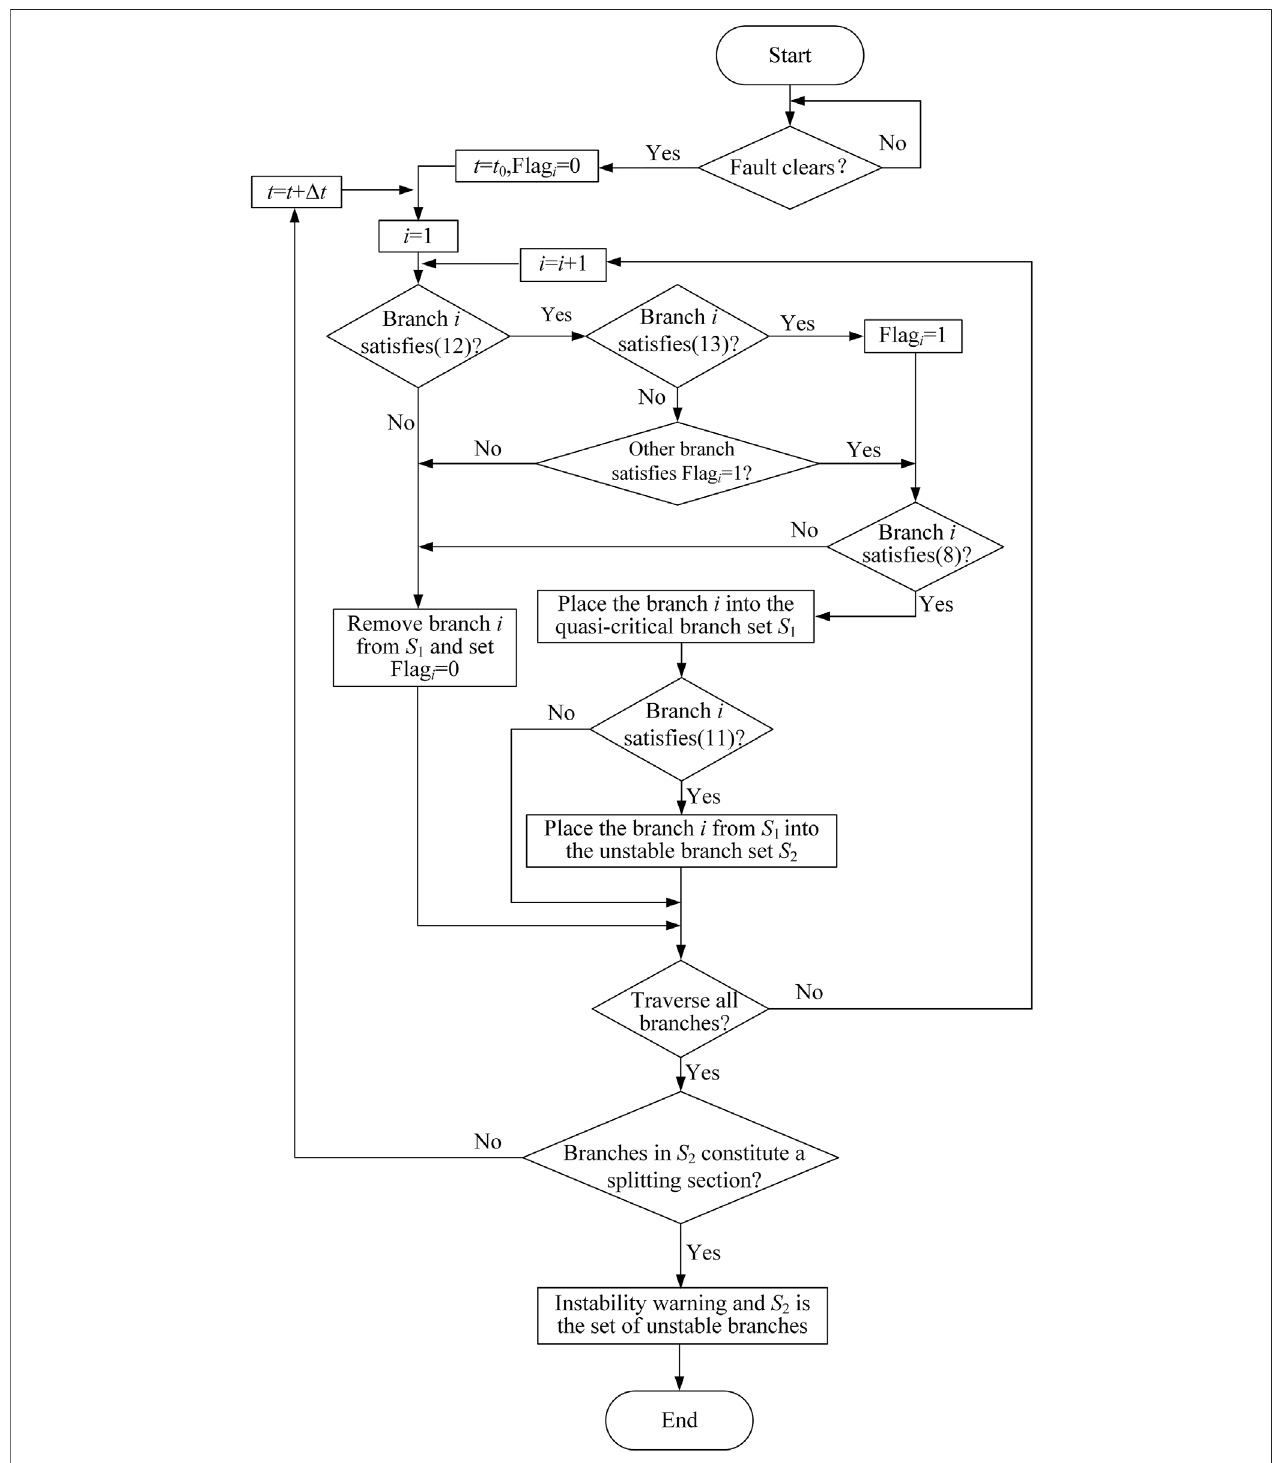
FIGURE 3 | Process of instability prediction and unstable branch screening.